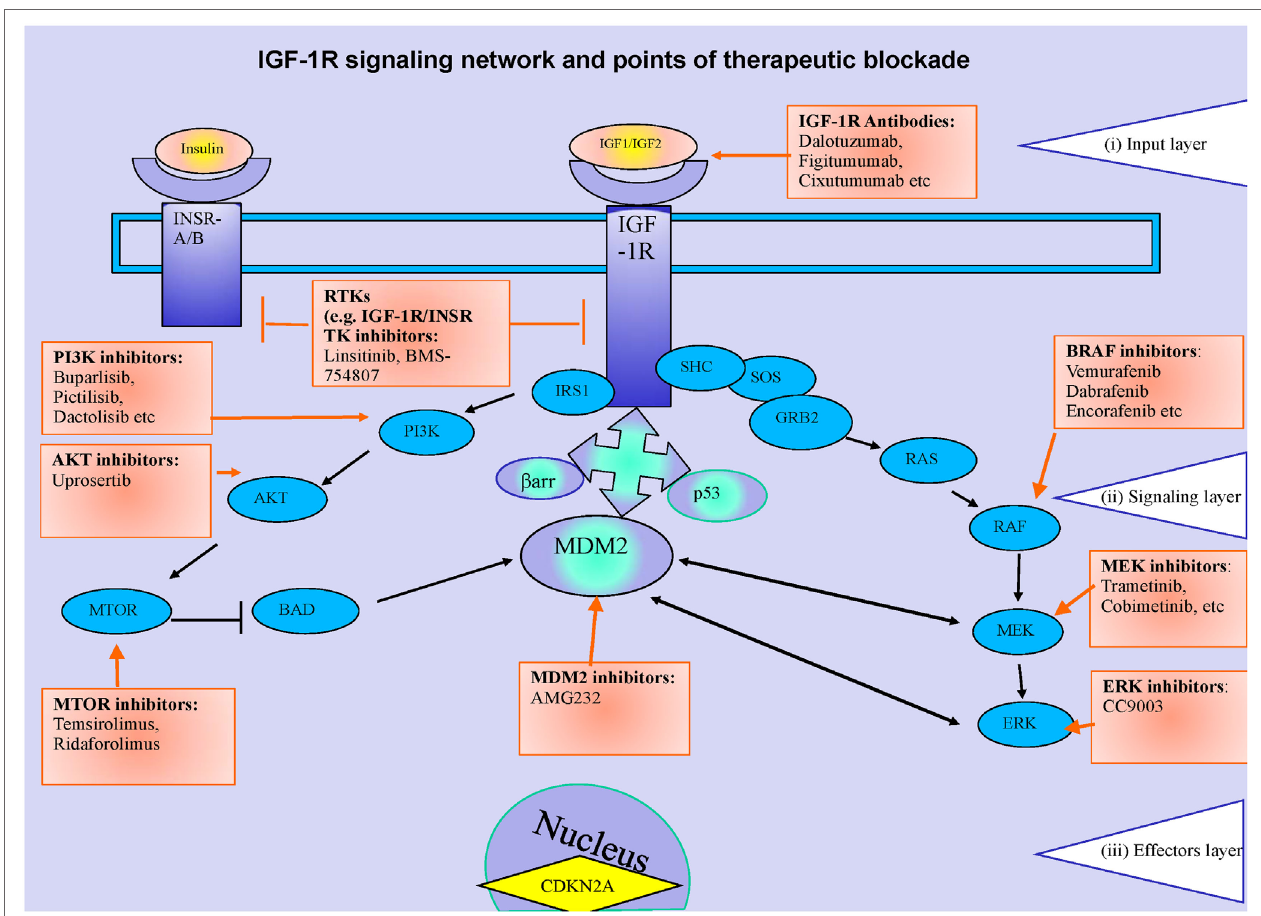
FiGURe 1 | Receptor tyrosine kinases (RTKs) (IGF-1R) signaling network and points of therapeutic blockade. The canonical RTKs signaling can be represented as a system of three layers. The input layer (i) is made up of ligands (e.g., insulin, insulin-like growth factor 1, IGF-2) and surface receptors (IGF-1R, insulin receptor). Ligand–receptor interaction initiates activation of the second layer (ii) (the signaling cascade) through recruitment of the two main adaptor proteins; Shc and the IRS’s. Through stepwise enzymatic activation, the signal cascade is set up, following two main routes—the mitogen-activated protein kinase (MAPK) route and the phosphoinositide 3-kinase (PI3K) route. The signaling cascade arms culminate in the activation of transcription factors in layer (iii), which control site specific transcription and generate the resulting biological effects. The molecular changes associated to melanoma pathogeny and hence potential therapeutic targets are indicated within each of the system’s